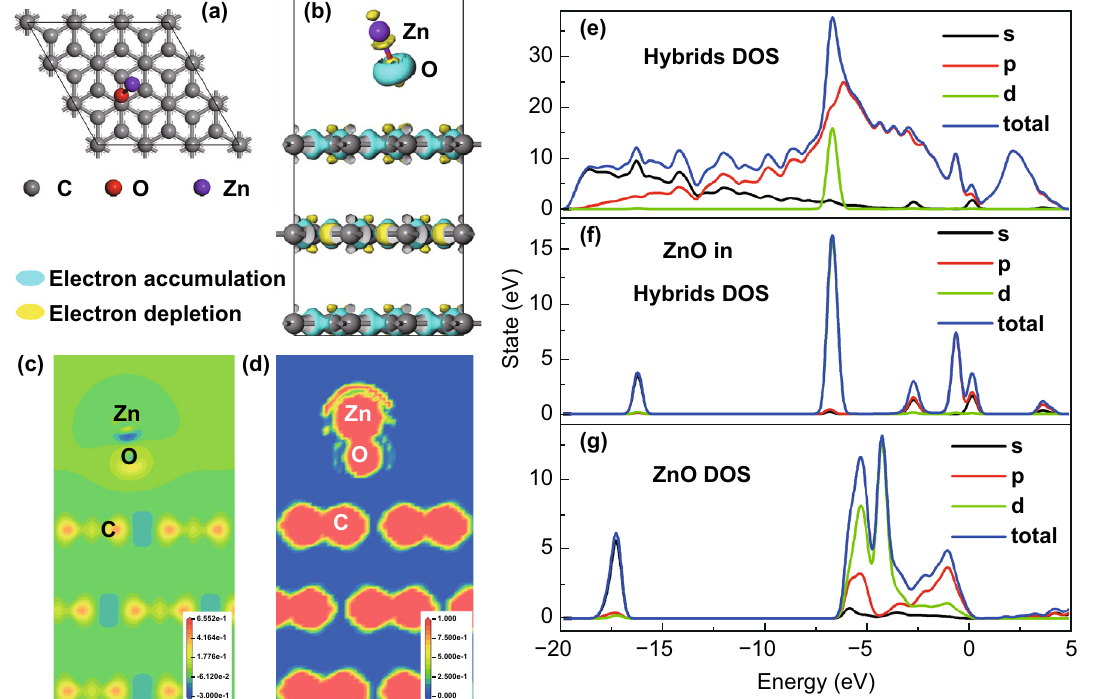
Fig. 4 Simulation results of ZnO/OMCS. a Top view of graphite/ZnO structure after relaxation; b side view of charge density difference map with isovalue of 0.1; slice of c charge density difference and d electron localization functional along (011) plane. DOS results for e graphite/ZnO hybrids, f ZnO in hybrids, g bare ZnO